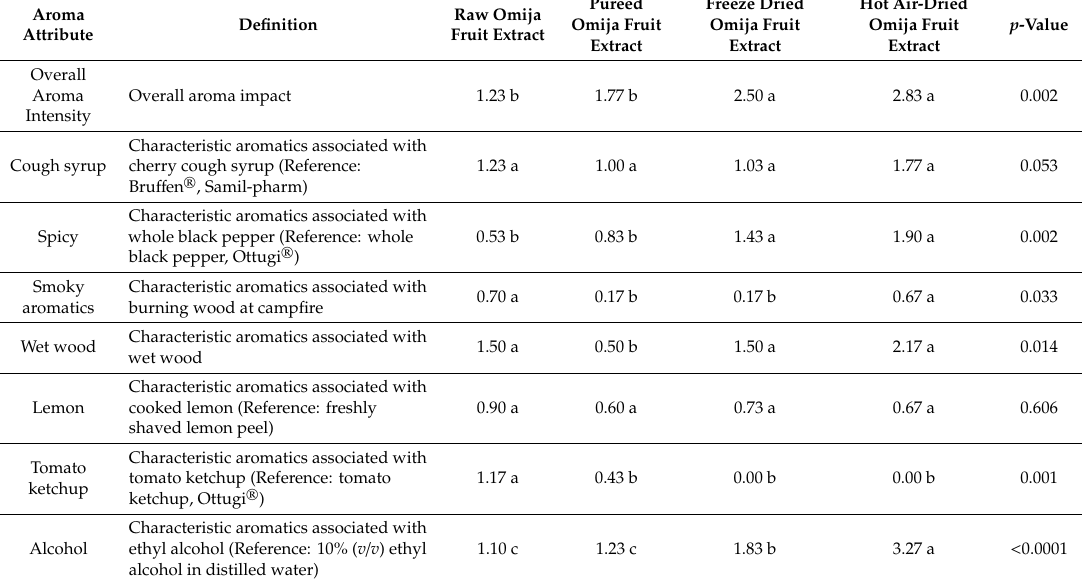
Table 3. Descriptive analysis result of omija fruit